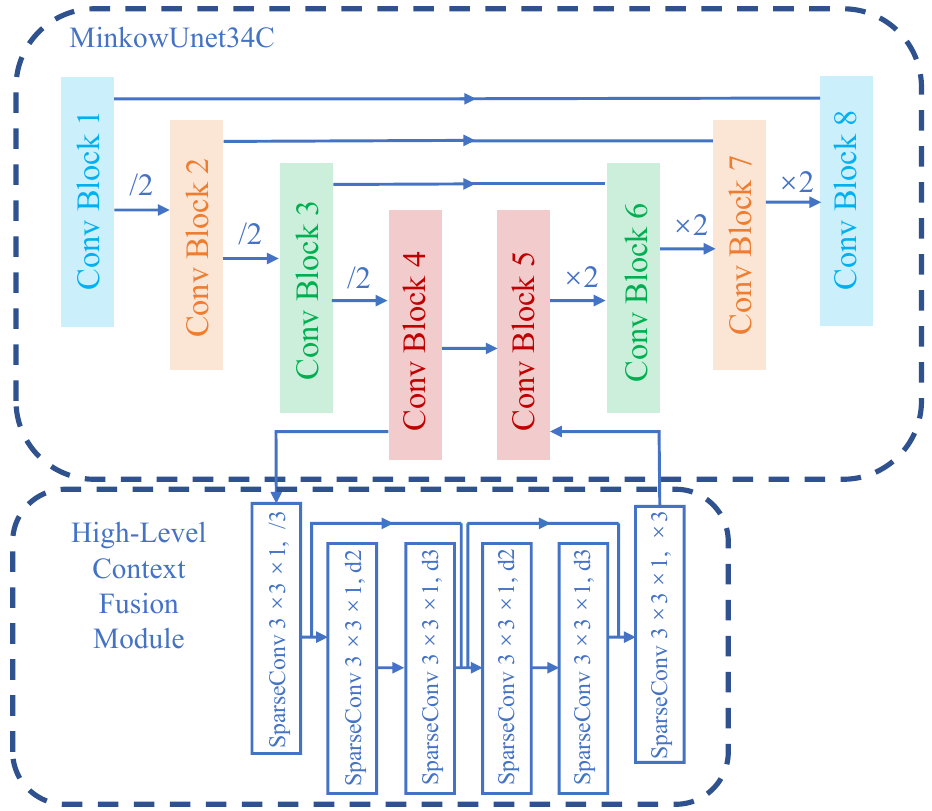
Figure 5. Network Architecture. Where /2 and × 2 denote down-sampling and up-sampling, respec- tively, with tensor stride size of 2, d2 and d3 denote dilation factor of 2 and 3, respectively, for sparse dilated